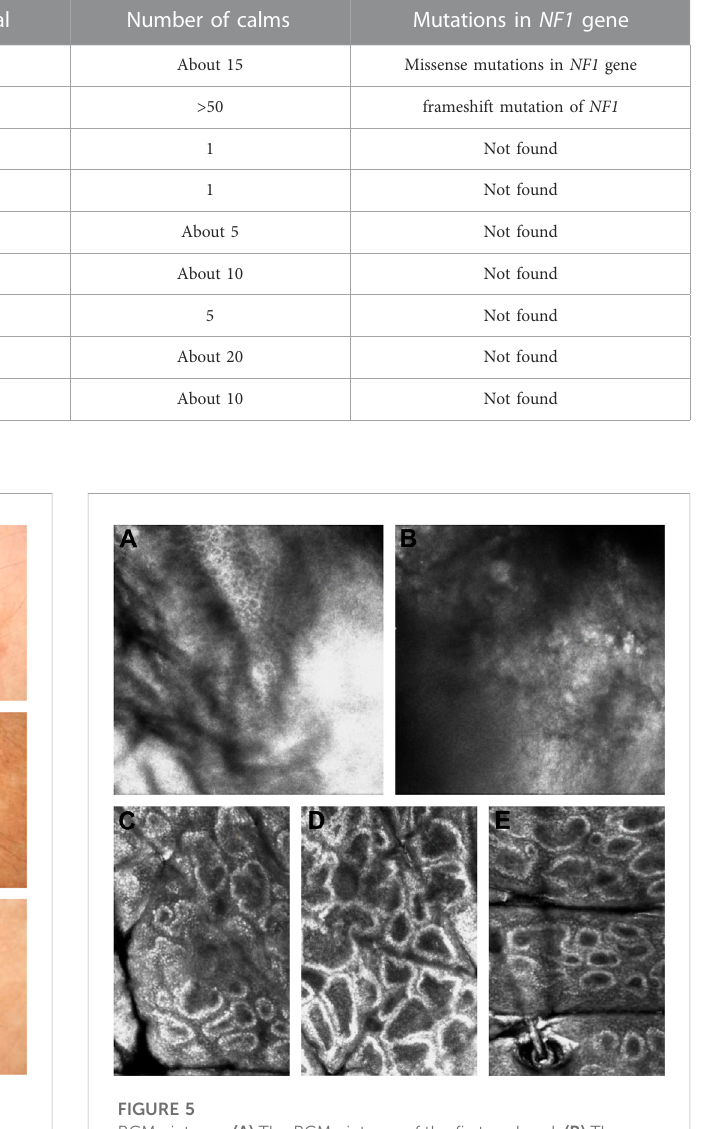
FIGURE 5 RCM pictures. (A) The RCM pictures of the fi rst proband. (B) The RCM pictures of the second proband. (C) The RCM pictures of the fourth proband. (D) The RCM pictures of the fi fth proband. (E) The RCM pictures of the sixth proband. The third proband did not have the RCM images due to the patient ’ s parents